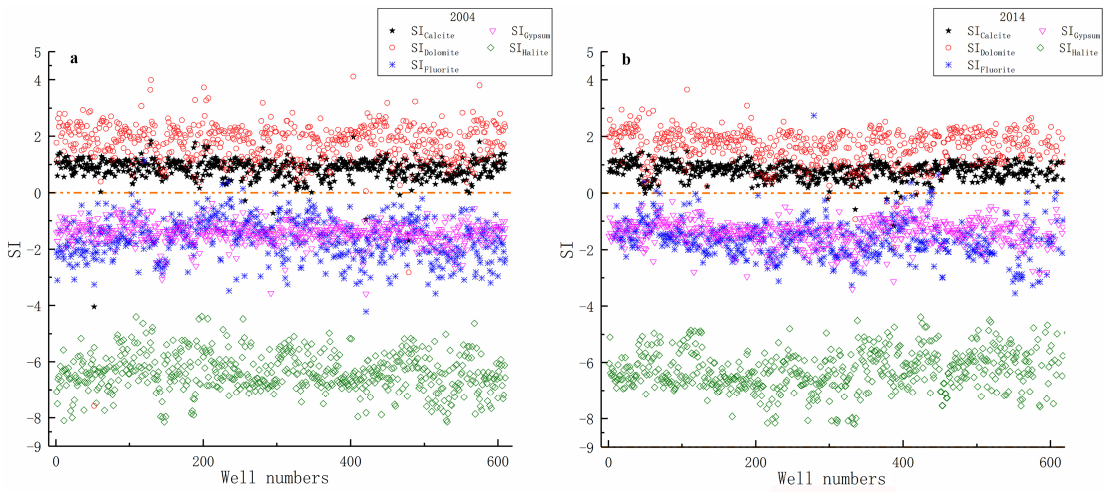
Figure 4. Saturation indices (SIs) for samples in ( a ) 2004 and ( b ) 2014.